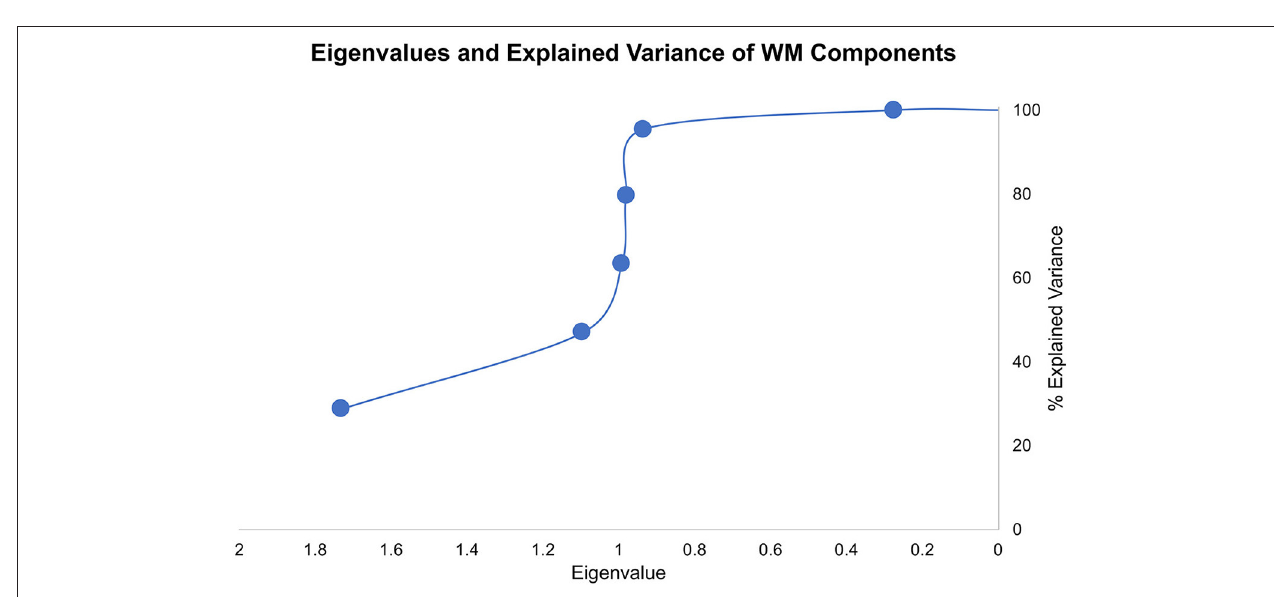
FIGURE 2 | Eigenvalues and explained variance of the WM components from